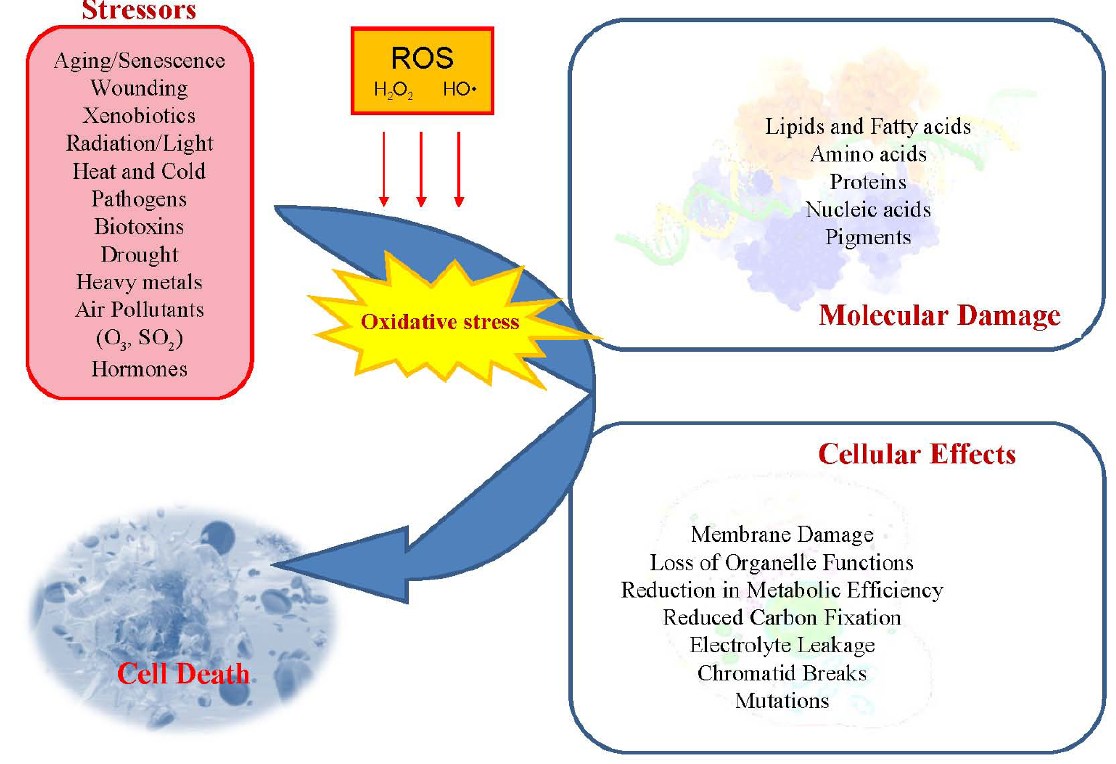
Figure 3. Scheme showing some of the initiators (stressors) of reactive oxygen species (ROS) and the biological consequences leading to a variety of physiological dysfunctions that can lead to cell death.